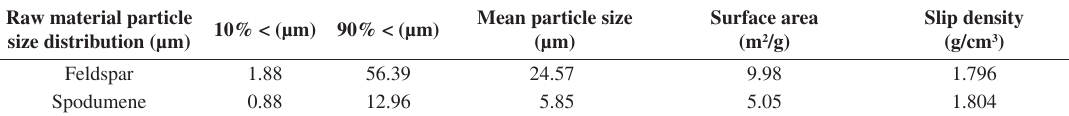
Table 3. Raw materials particle size distribution, surface area and slip density used in slip casting analysis.